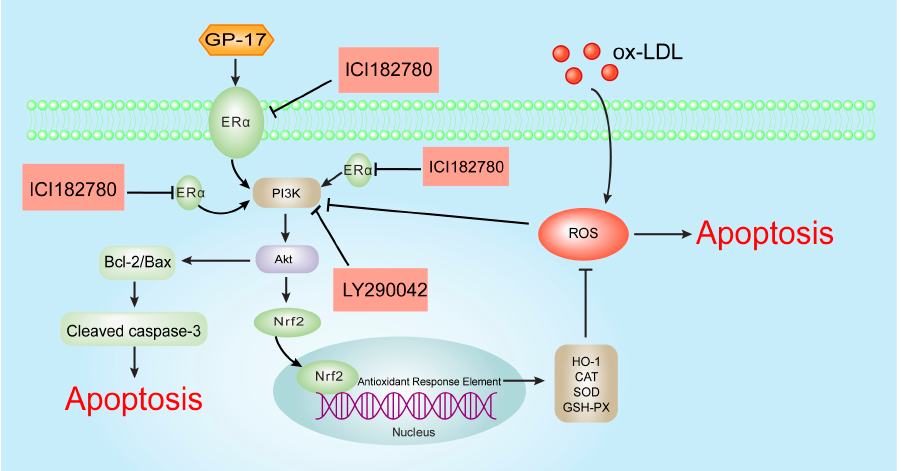
Figure 12. The molecular mechanism of the GP-17 anti-atherosclerotic effects. ROS induced by Ox-LDL result in endotheliocyte apoptosis and oxidative stress. GP-17 activates the ER α -mediated PI3K/Akt pathway, further resulting in Nrf2/HO-1 up-regulation and increasing the level of antioxidant enzymes. This process attenuates Ox-LDL-induced oxidative injury. Furthermore. GP-17 inhibited Ox-LDL-mediated HUVEC apoptosis by decreasing the ratio of Bax to Bcl-2 and controlling cleaved caspase-3 activation. This process inhibits Ox-LDL-induced endothelial cell apoptosis via the ER α -mediated PI3K/Akt pathway. T bars represented inhibition and arrows represented activation.